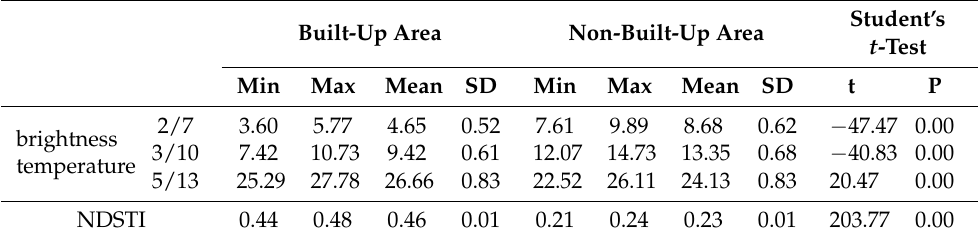
The color of built-up area is light blue and homogeneous. Their boundary is clear. The spatial location is explicit. Table 3. The statistical analysis for brightness temperature (°C) and normalized difference of